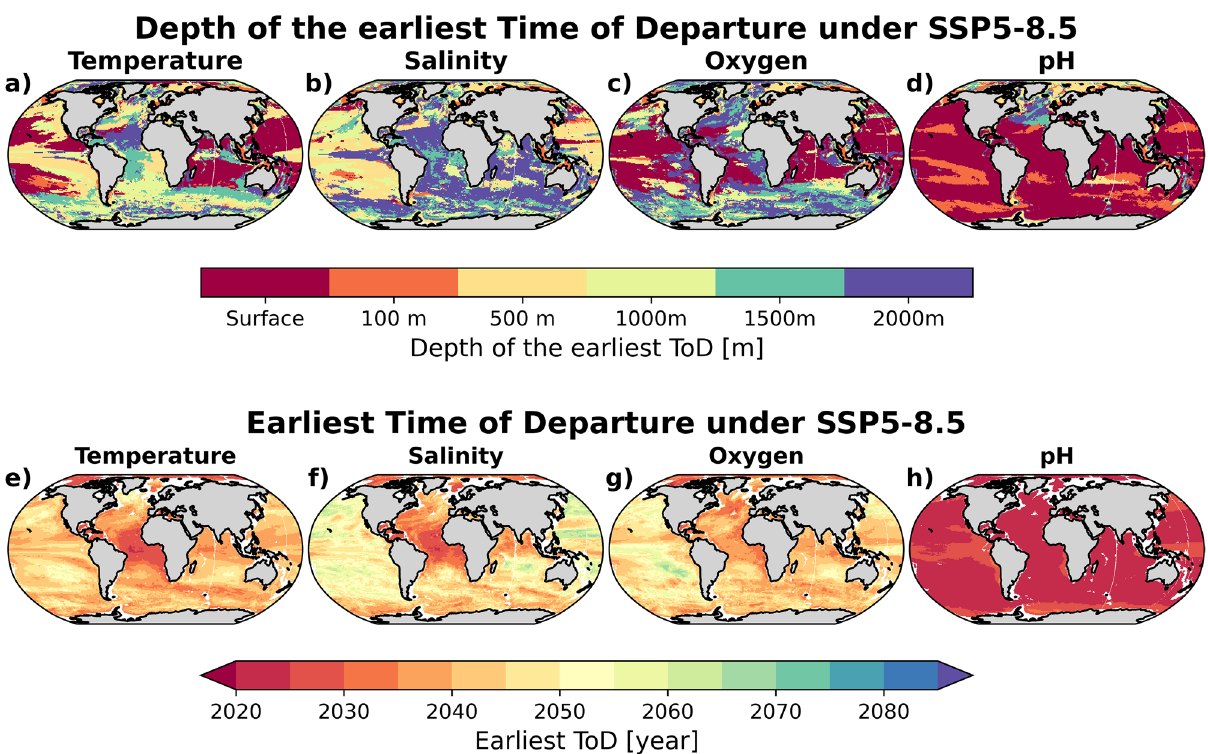
mean of ToD for ( e ) temperature, ( f ) salinity, ( g ) oxygen, and ( h ) pH. Values are estimated from Earth system model projections under the SSP5-8.5 future scenario. Maps were generated with Python 3.9.16 using Matplotlib v3.6.2 (https:// matpl otlib. org/) and Cartopy v0.21.1 (https:// scito ols. org. uk/ carto